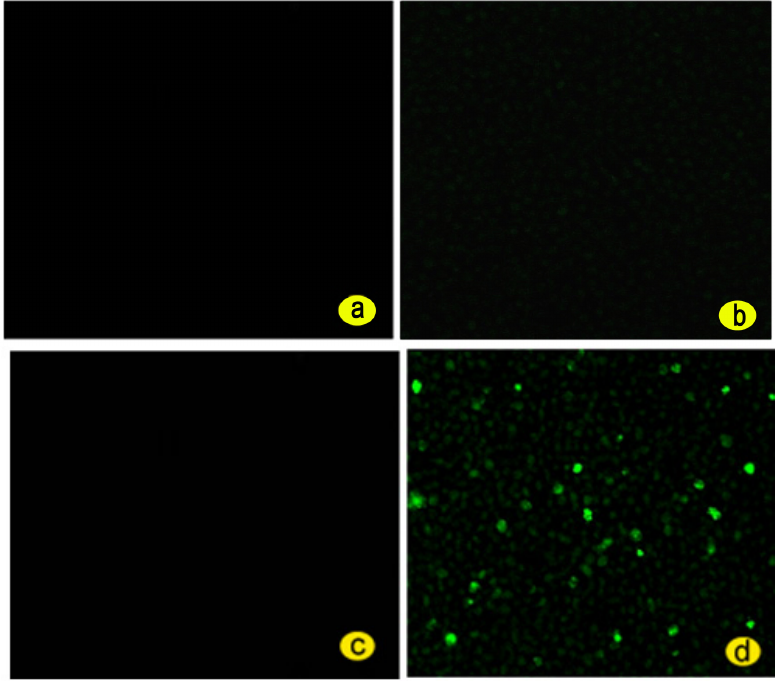
Figure 3. The laser confocal microscopic images of the control K562 group cells ( a ) without and ( b ) with Intervention of the fluorescein isothiocyanate (FITC)-labeled single-stranded DNA probe, and the images of the experimental NB4 group cells ( c ) without and ( d ) with Intervention of the FITC-labeled single-stranded DNA probe.